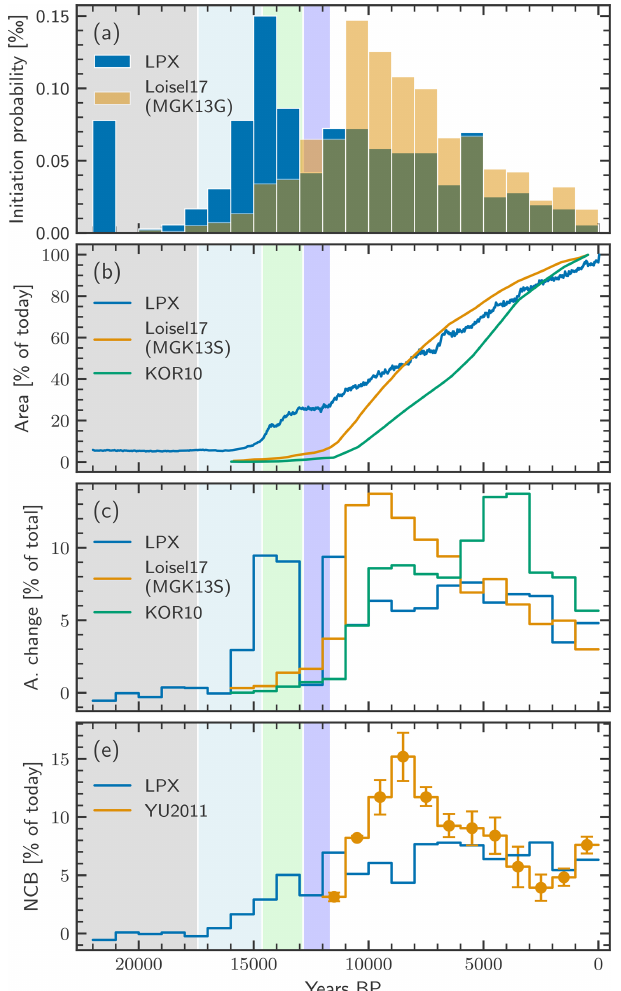
Figure 7. Simulated and reconstructed dynamics of today’s exist- ing northern peatlands: (a) peatland initiation frequency (two over- lapping histograms), (b) peatland area expansion and (c) expansion rate, and (d) the net carbon balance (NCB) normalized by respec- tive estimates of today’s carbon pool. The reconstruction datasets are described in Sect. 2.3. The background colors indicate different time periods, as in Fig.